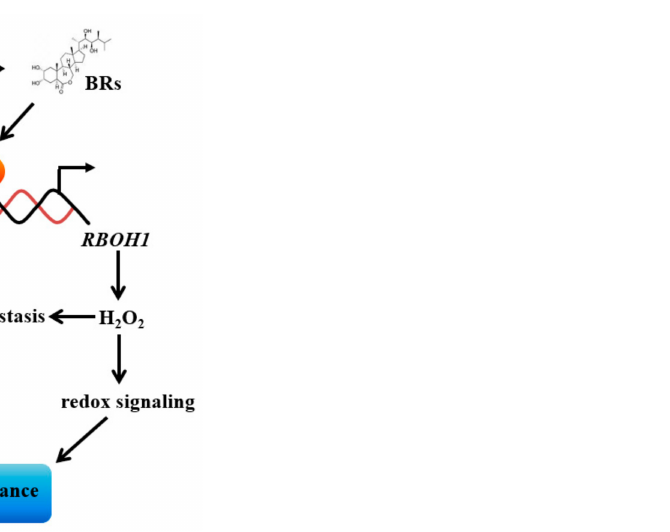
Figure 7. A proposed model of the crosstalk of BZR1 and ROS in CBF induction. Cold increases BR biosynthesis and the abundance of BZR1. While BZR1 positively upregulates the expression of CBFs and RBOH1 by binding to the conserved E-box/BRRE motifs of their promoters, RBOH1 -dependent production of apoplastic H 2 O 2 in turn modulates the redox status to increase the BZR1 abundance, transcription of CBF genes, and subsequent cold tolerance.